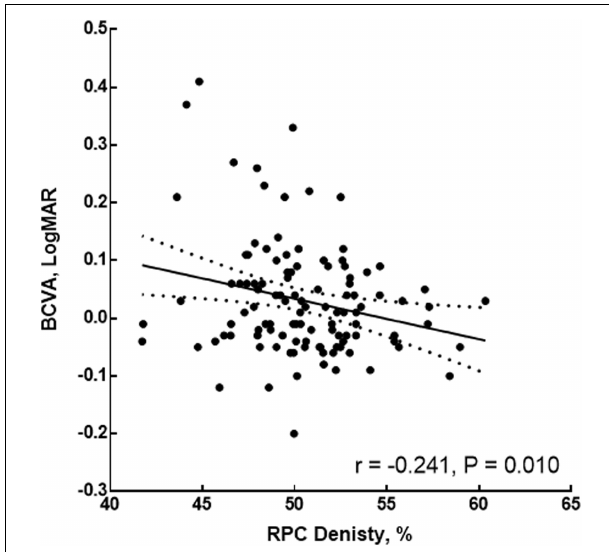
FIGURE 3 | Correlation of the RPC density and BCVA after adjustment for the AL. RPC, radial peripapillary capillary; AL, axial length; BCVA, best-corrected visual acuity.